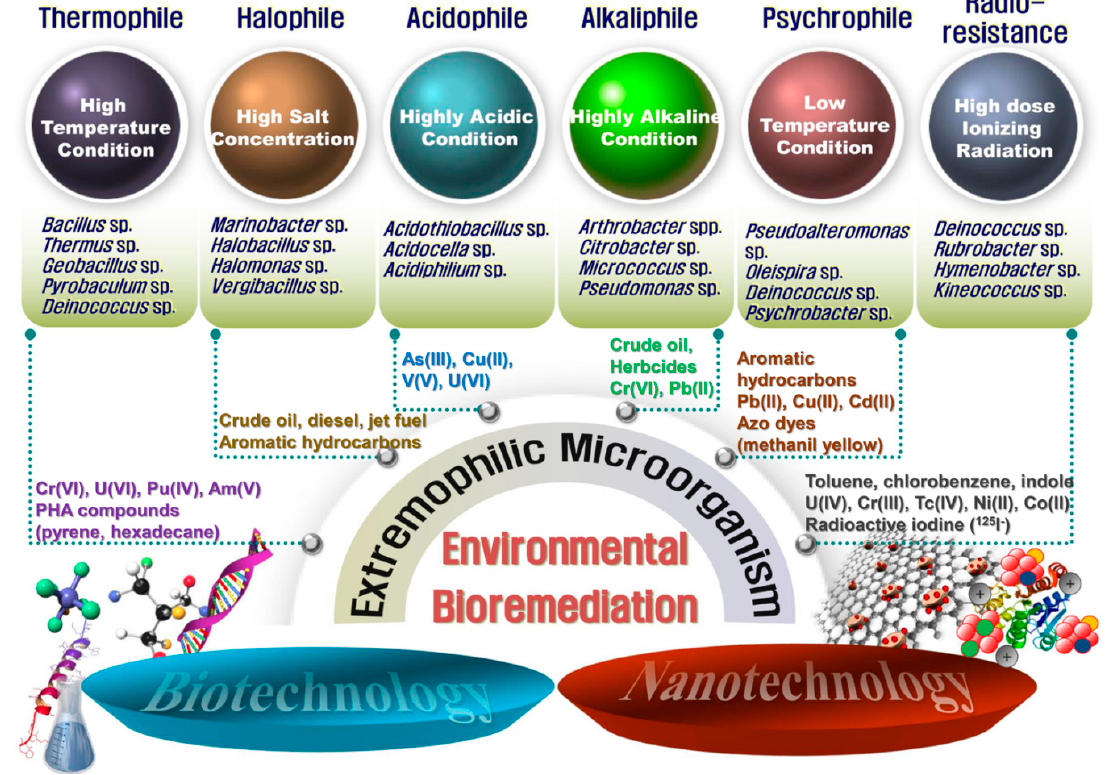
Figure 2. A schematic diagram of advanced bioremediation using extremophilic microorganisms combined with biotechnology and nanotechnology. Representative candidates that can be used as a host strain for the treatment of pollutants in the environment are shown.